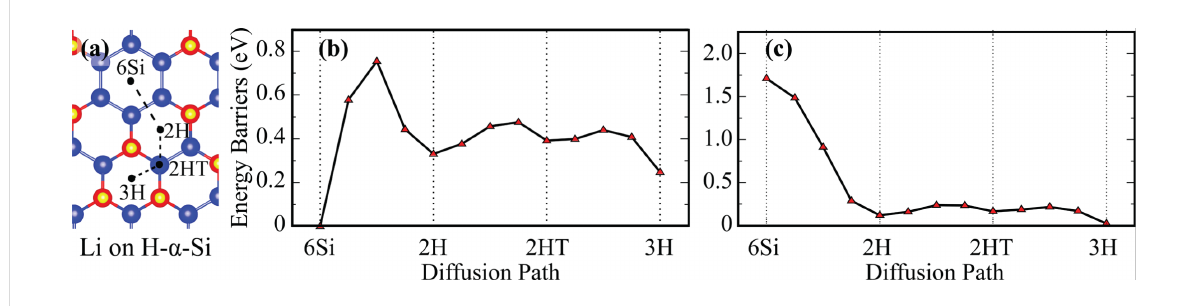
Figure 2: (a) Top view of possible adsorption sites for a Li atom on H- α -Si. Energy barrier graphs of (b) the first and (c) the second Li atom on H- α -Si. A possible diffusion path of a Li atom is illustrated by dashed black lines.